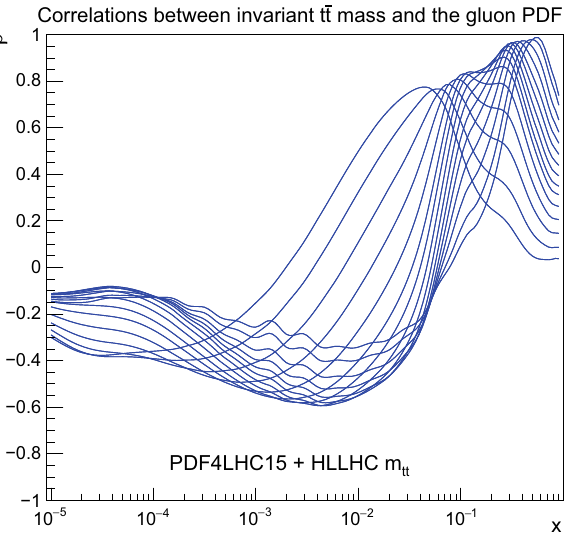
Fig. 7 As in Fig. 4, now for the correlation coefficient between the gluon PDF and the various bins of m t ¯ t , the invariant mass of the top quark